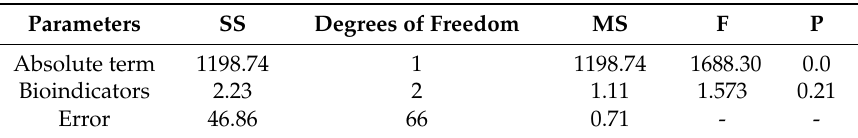
Table 9. Results of Tukey’s HSD test for significance of differences between the organisms tested.